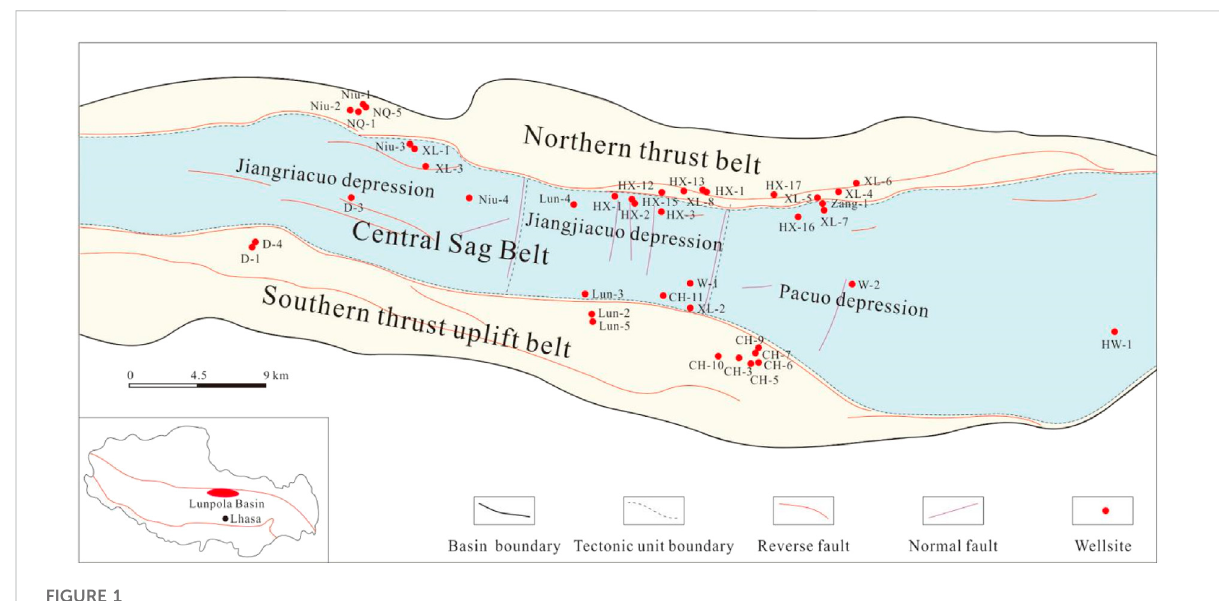
FIGURE 1 The tectonic division map of the Lunpola